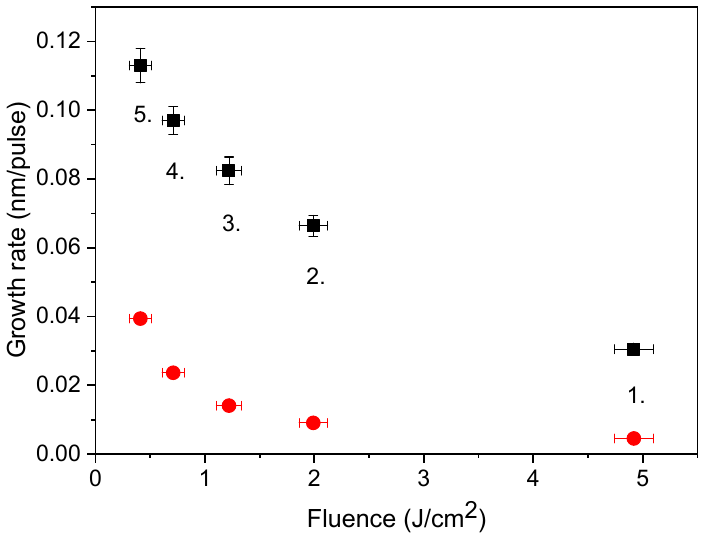
Figure 8. Comparison of growth rates of copper films deposited by sub-ps UV pulses: this work ( ■ ) and data points from [40] converted for the same spot sizes ( ● ).